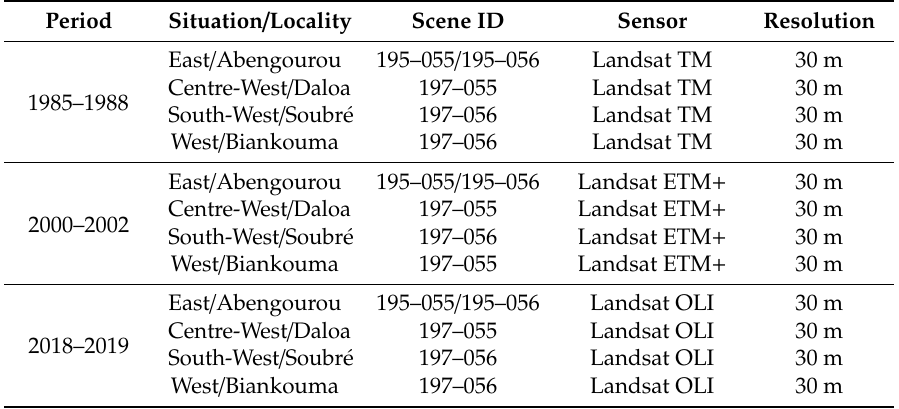
Table 1. Satellite images